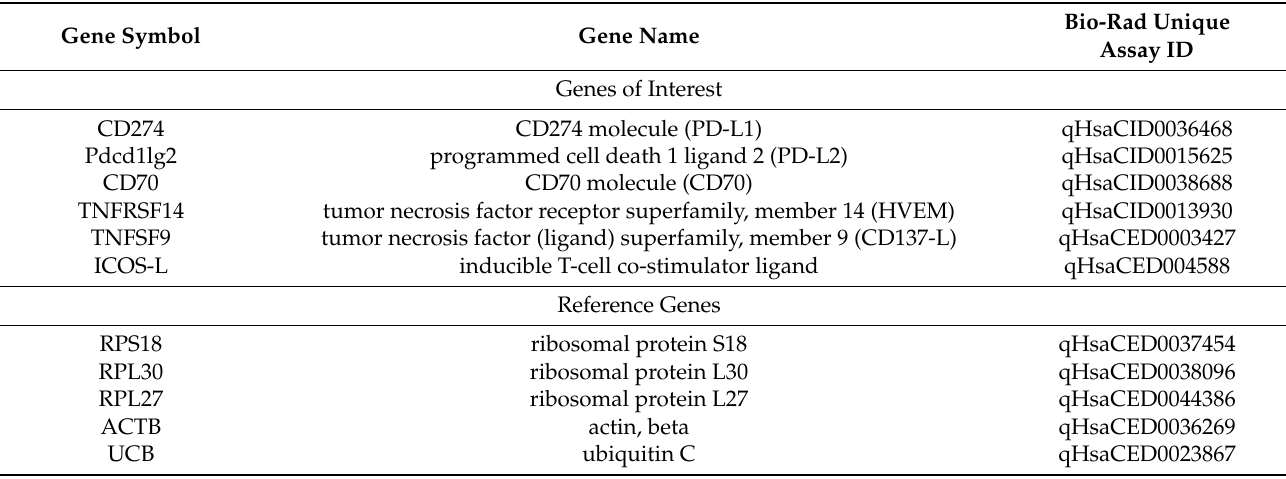
Table 2. List of primers of genes of interest and reference genes used for qPCR